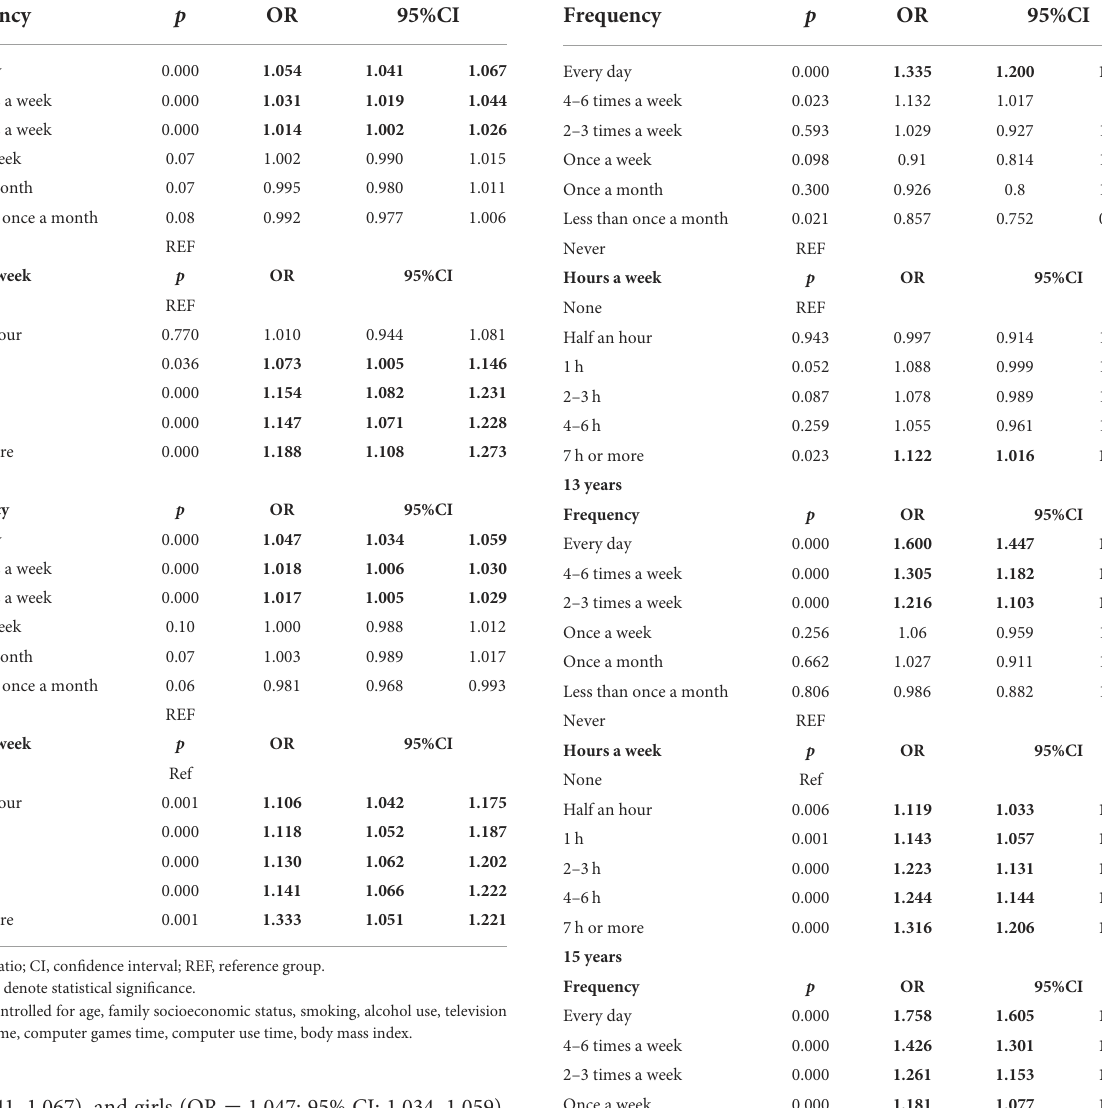
TABLE 3 Association between vigorous physical activity and life satisfaction by age